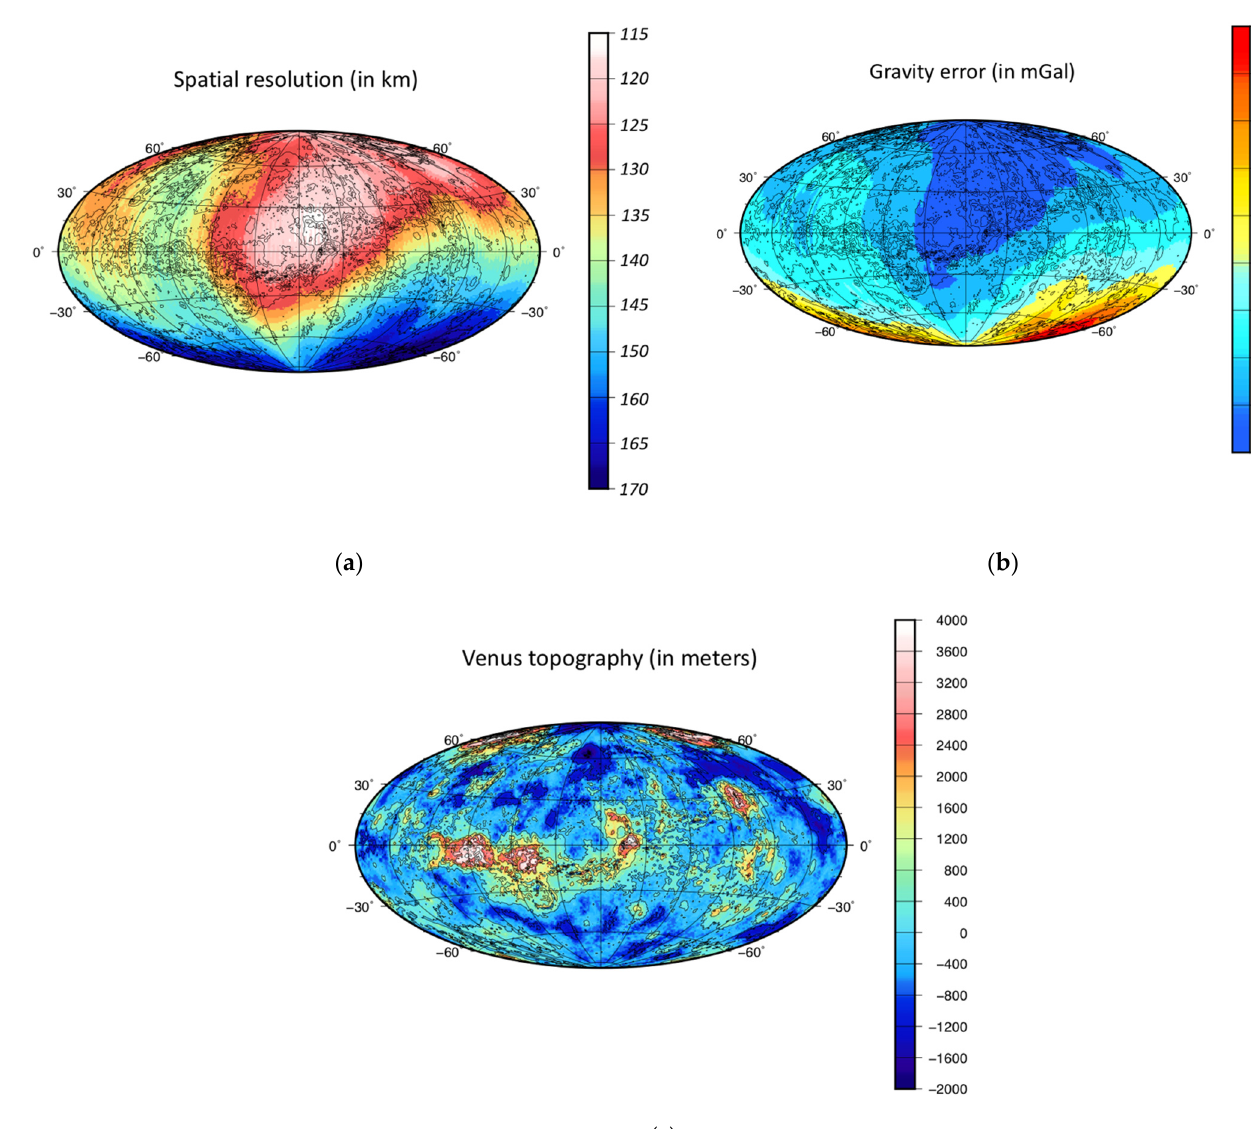
Figure 1. Expected EnVision maps (in Hammer–Aitoff projection) of ( a ) the spatial resolution, ( b ) the cumulated gravity error (1- σ ) from the degree 2 to 110. The isocontours of the Venus topography [43] are shown in the background, and ( c ) the Venus topography map (in planetary radius above 6051 km [43]).